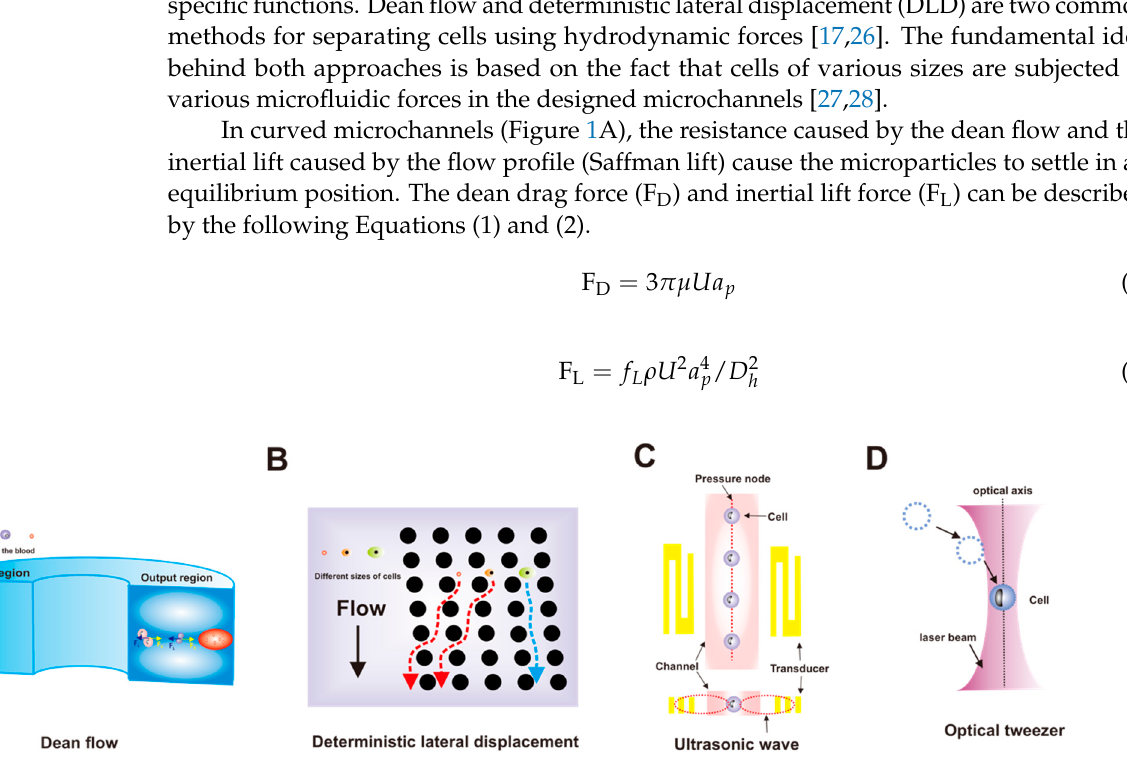
Figure 1. Schematic of cell separation principles. ( A , B ) Hydrodynamic forces act on the cells in the microchannel system. Reproduced with permission from Zhang et al., Lab Chip 21(22), 4414–4426 (2021). Copyright 2021 The Royal Society of Chemistry [26]. ( C ) The ultrasonic waves produced by transducers are used as the acoustic primary radiation force for acoustic cell separation. ( D ) The gradient forces of the laser beam are applied using optical tweezers. Reproduced with permission from Park et al., Journal of Micromechanics and Microengineering, 26(1), 013003 (2016). Copyright 2016 IOP Publishing [25].